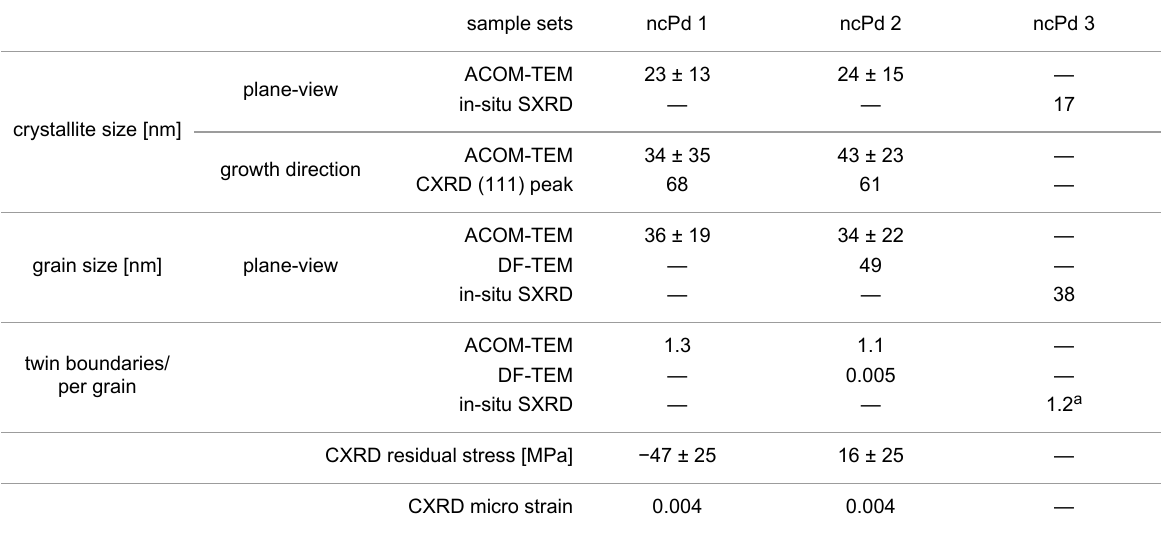
Table 1: Overview of the structural properties of the three ncPd sample sets analyzed using different techniques before straining.